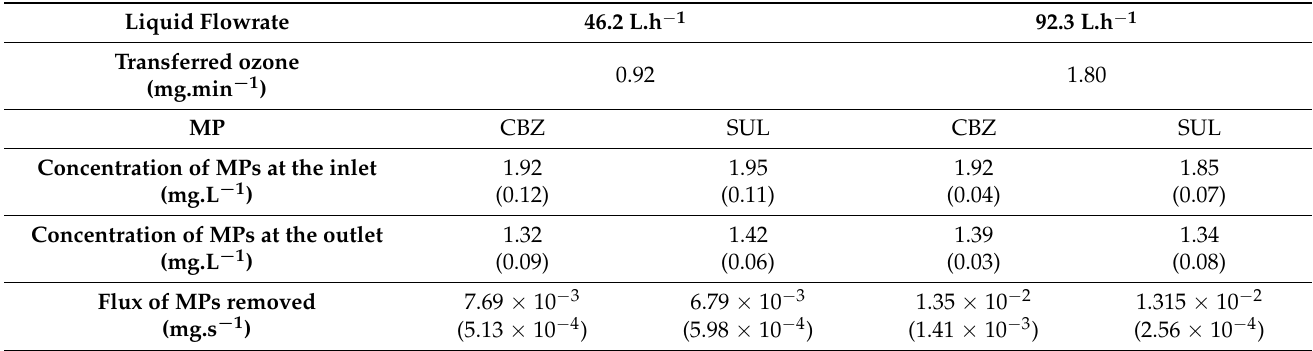
Table 6. MP elimination rates and transferred ozone in experiments run at the two liquid